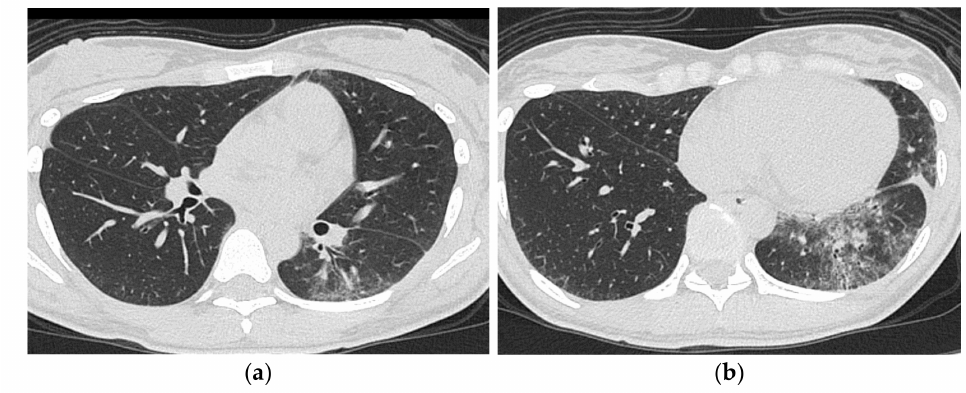
Figure 9. A 30-year-old man with nonspecific interstitial pneumonia pattern associated with der- matomyositis (anti-ARS Ab positive). HRCT images ( a , b ) shows bilateral ground-glass opacification and reticulation with peribronchovascular predominance. Mild traction bronchiectasis and decreased volume in the left lower lobe was also